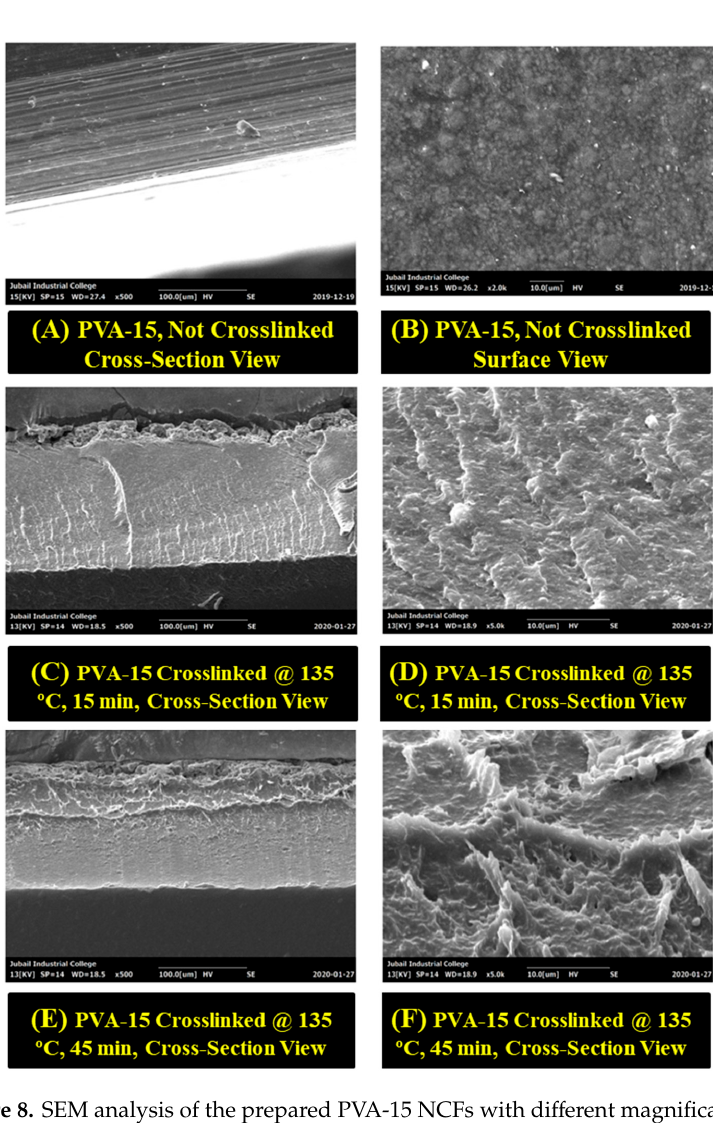
Figure 8. SEM analysis of the prepared PVA-15 NCFs with different magnifications.